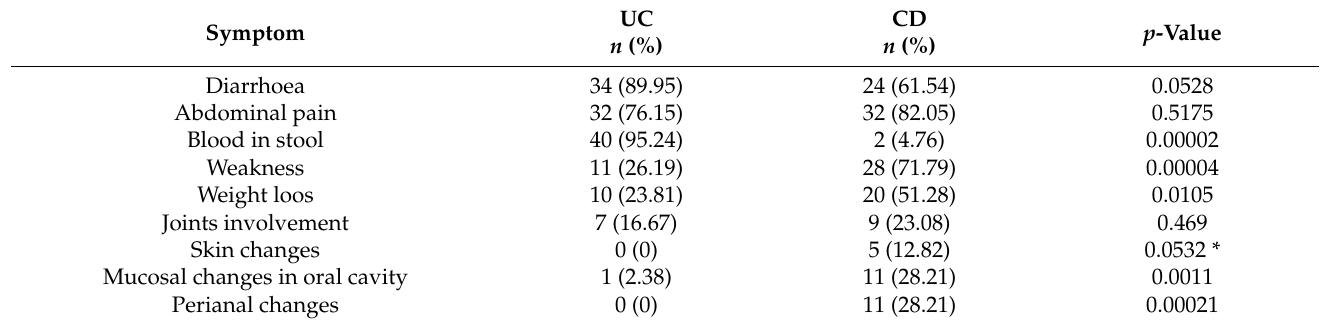
Table 5. Frequency of symptoms in children with newly diagnosed IBD.